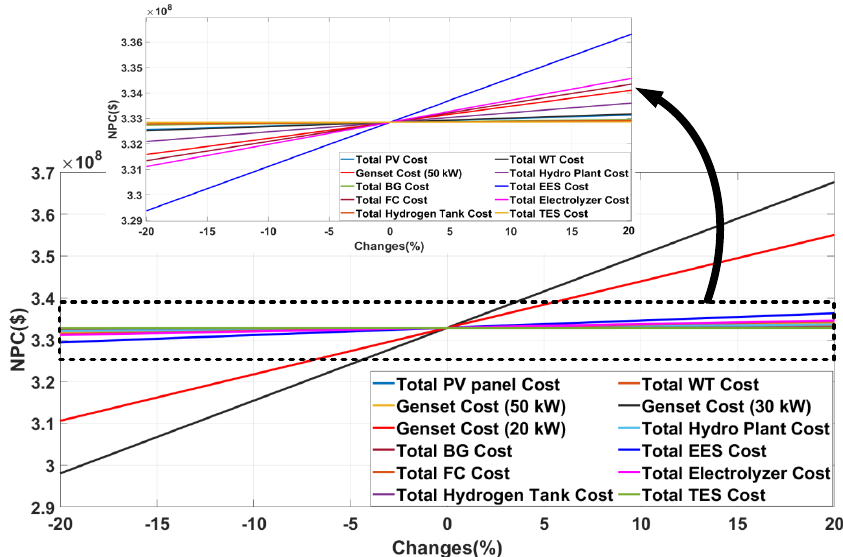
Figure 21. Impact on NPC due to variation in system component cost (Case-01). Energies 2020 , 12 , x FOR PEER REVIEW